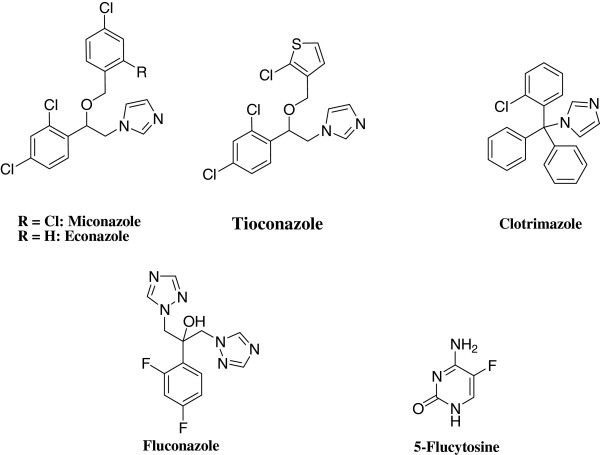
Chemical structures of common antifungal azole drugs.